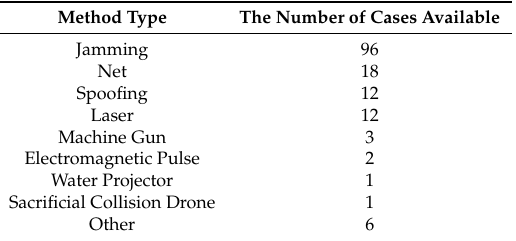
Table 1. Counter-drone techniques available according to